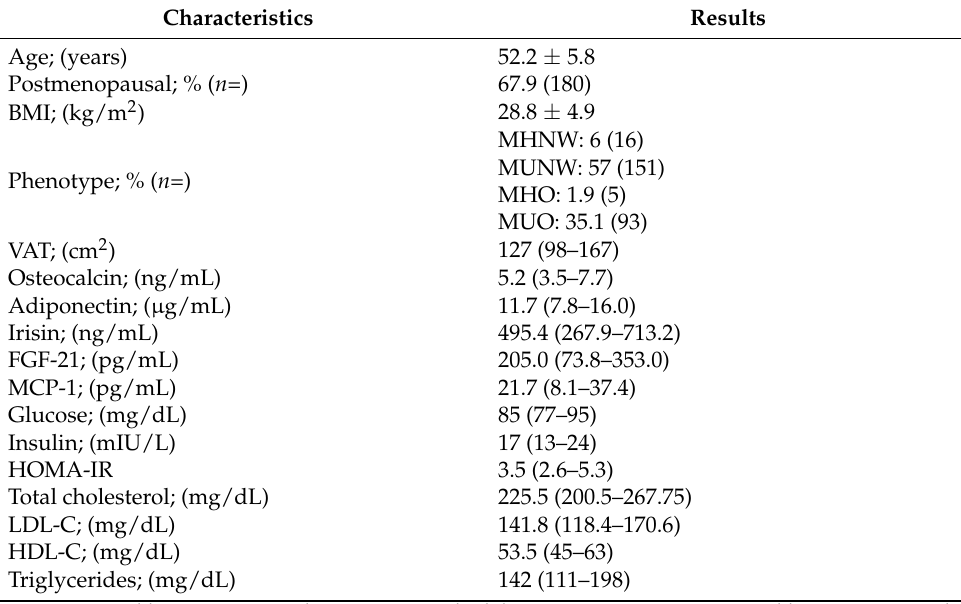
Table 1. Baseline characteristics of the middle-aged women included in the